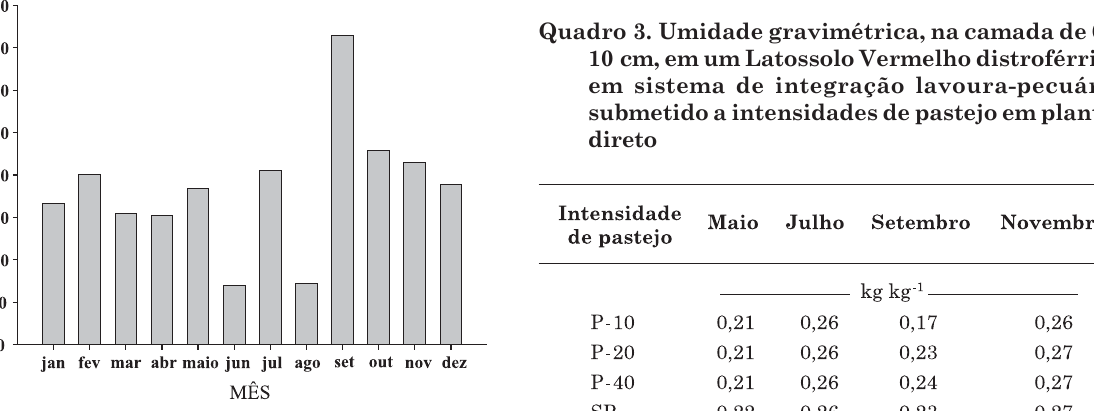
Figura 1. Precipitação pluvial no ano de 2007 na fazenda do Espinilho, em São Miguel das Missões/